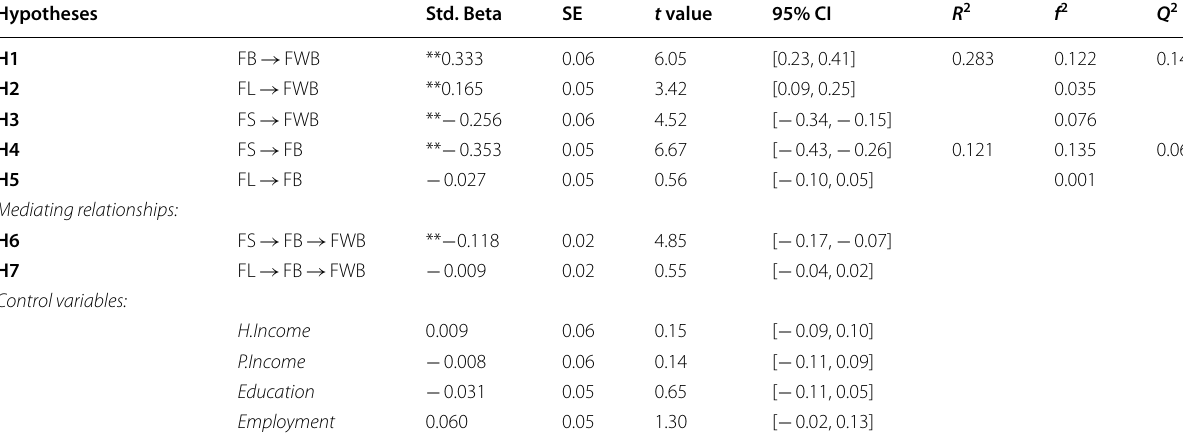
Table 7 Structural model assessment and hypotheses